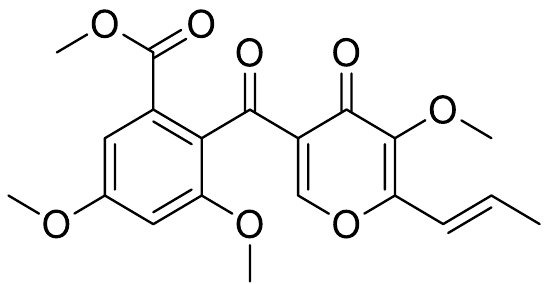
Figure 1. Chemical structure of 3- O -methylfunicone (OMF).